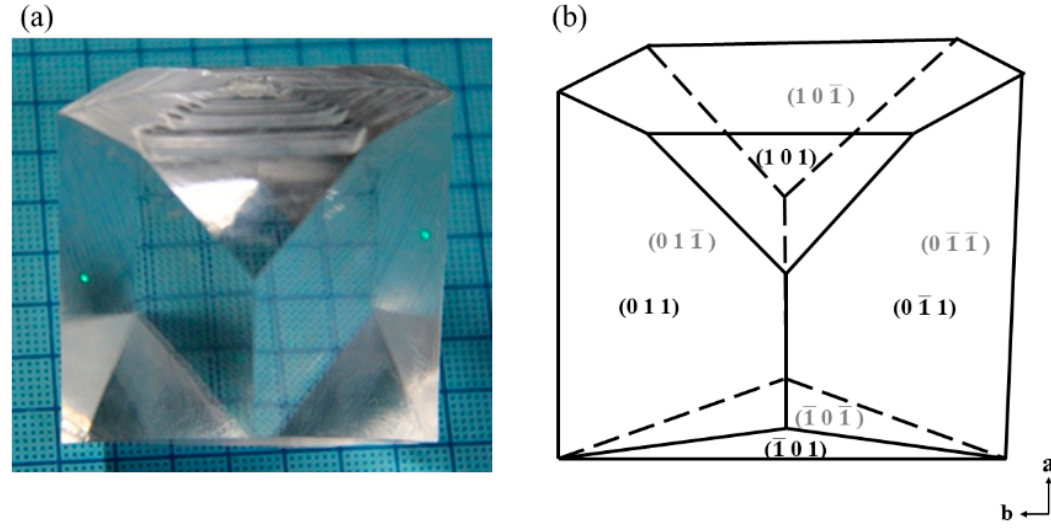
Figure 4. ( a ) CBO crystal grown using the TSSG method and ( b ) schematic morphology. Two CBO crystal blocks with 6 × 6 × 10 mm 3 dimensions along the c axis were cut from the as-grown crystals and then polished for spectroscopic measurements. The transmission spectra in the spectral range of 185–3000 nm were measured using a Lambda 900 spectrophotometer, as shown in Figure 5. The results indicated that the CBO crystals grown using two methods both had a transmittance greater than 80% and no obvious absorptions in the 200–2000 nm range. Two crystal wafers with 8 × 8 × 3 mm 3